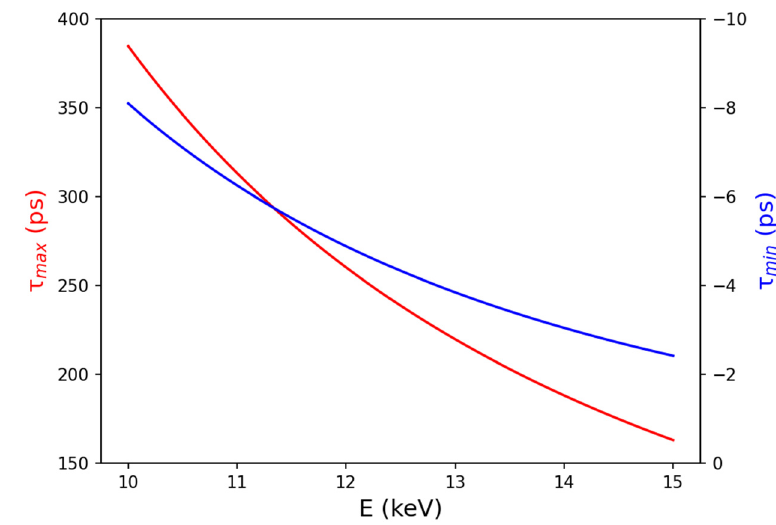
Figure 2. Calculated maximum and minimum delays of the hybrid SDL in the photon energy range of 10–15 keV.